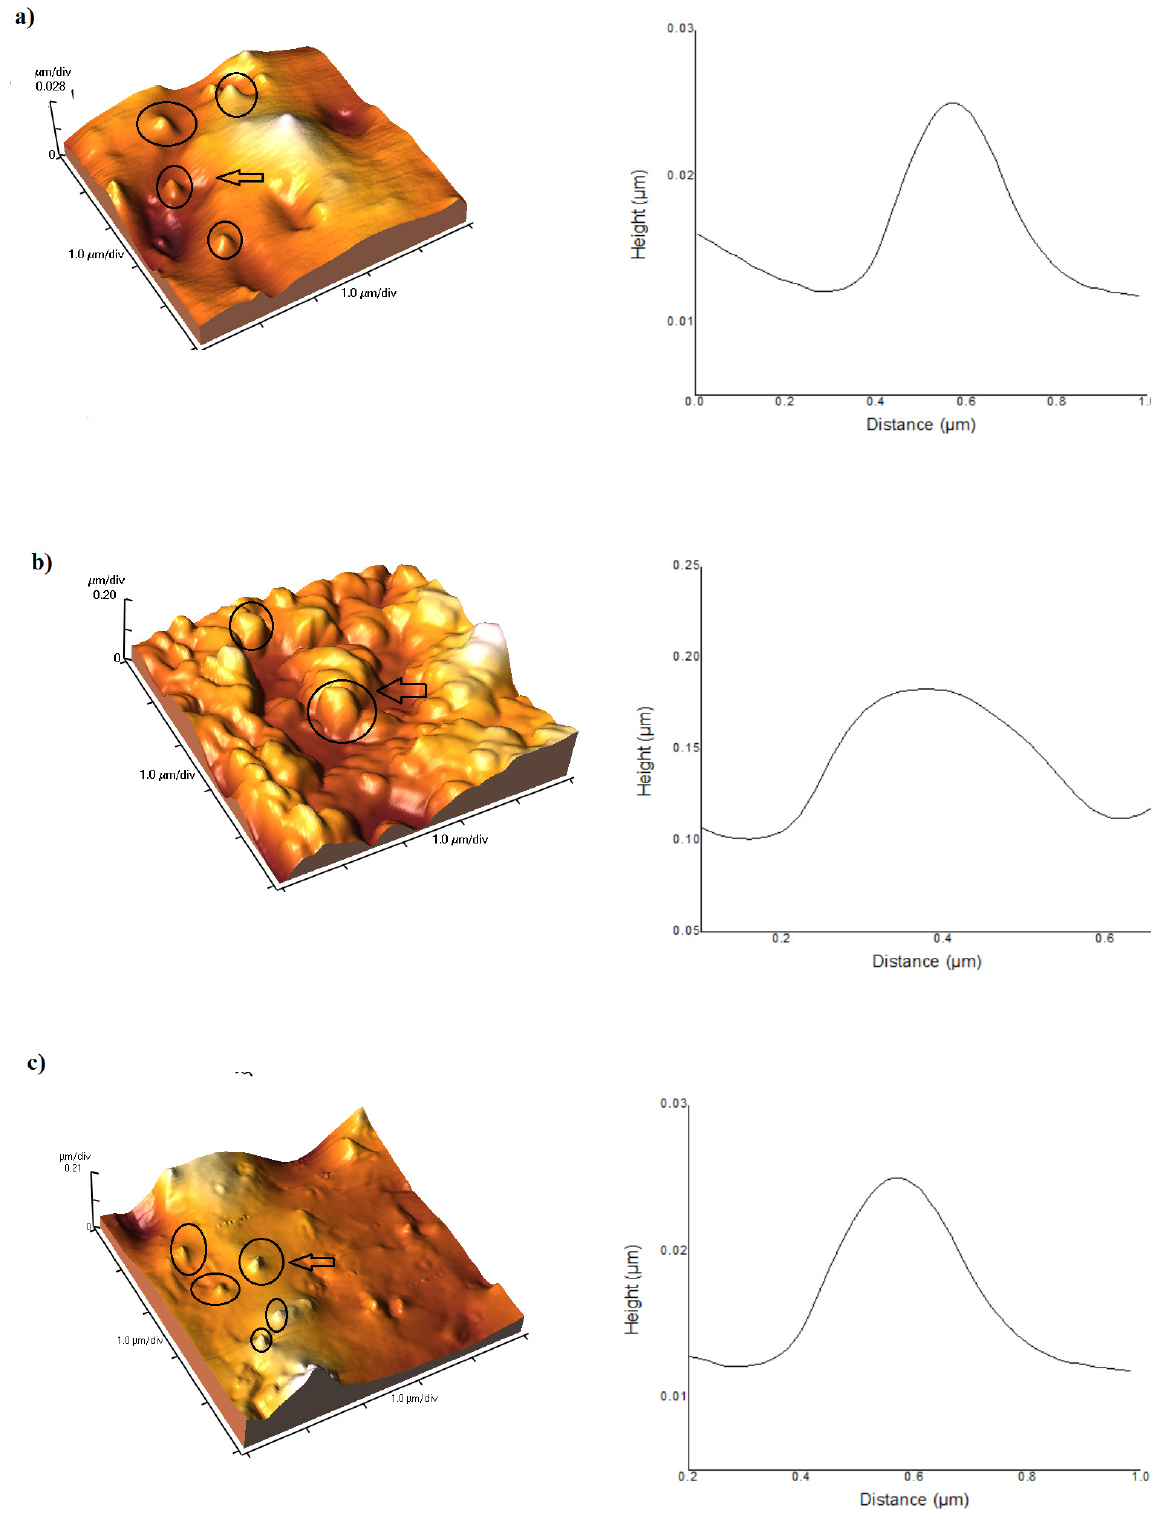
Figure 3: 3D atomic force microscopy images of the investigated curcumin nanocrystal dispersions and corresponding height-distance profiles for selected particles (marked with an arrow): a) F_P80; b) F_P80/SP_2:1; c) and d)